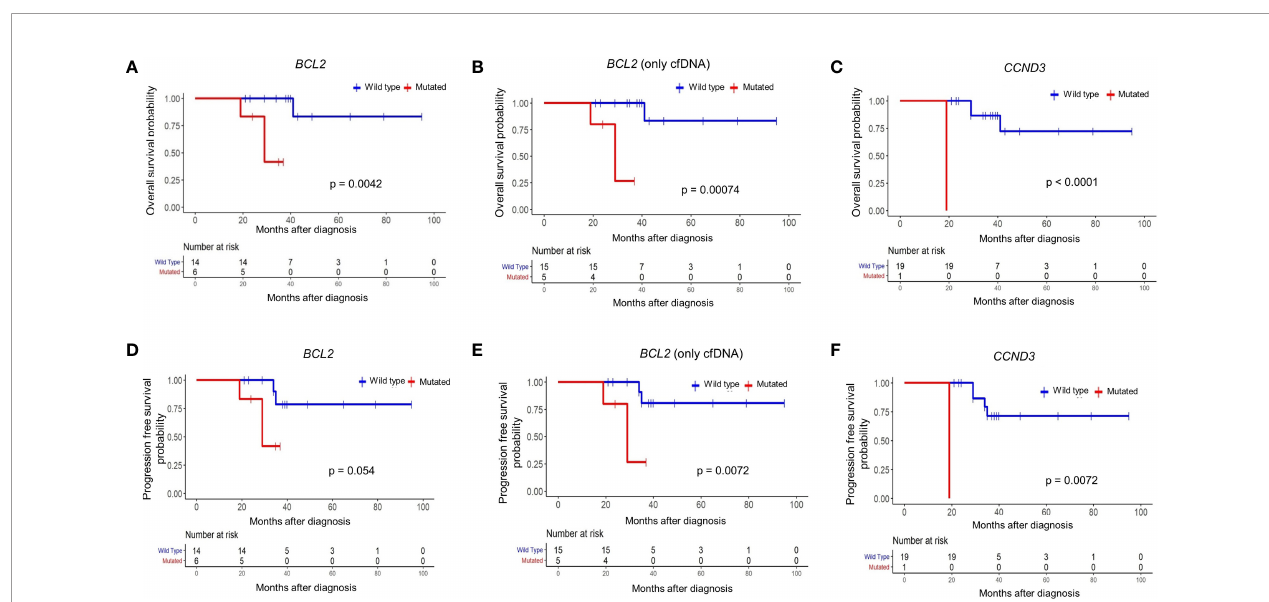
FIGURE 4 | BCL2 mutations in plasma cfDNA predict poor prognosis in follicular lymphoma. Kaplan-Meier plots showing overall survival for FL patients based on mutation status of BCL2 gene in cfDNA and/or tumor tissue DNA (A) , BCL2 gene in only cfDNA (B) , or CCND3 gene in cfDNA and/or tumor tissue DNA (C) . Kaplan-Meier plots showing progression-free survival for FL patients based on mutation status of BCL2 gene in cfDNA and/or tumor tissue DNA (D) , BCL2 gene in only cfDNA (E) , or CCND3 gene in cfDNA and/or tumor tissue DNA (F) . p-values represent the statistical signi fi cance based on the log-rank test.